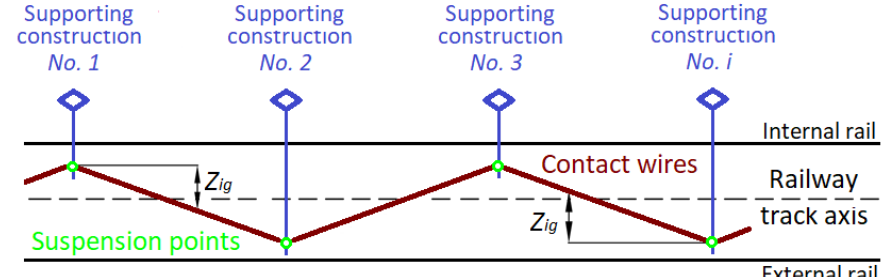
Figure 5. Stagger of the contact